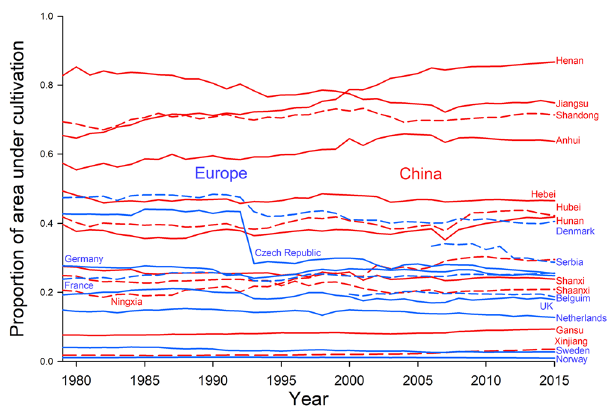
Fig. 5 Trends of land use in Europe and China. Provinces in China (red) or countries in Europe (blue) with signi fi cant positive patterns of the proportion of land in agricultural use over time were Anhui, Henan, Hubei, Hunan, Ningxia, Shandong, Xinjiang, and France and those with signi fi cant negative patterns were Jiangsu, Shaanxi, Shanxi, Czech Republic, Denmark, Germany, Netherlands, Serbia, and